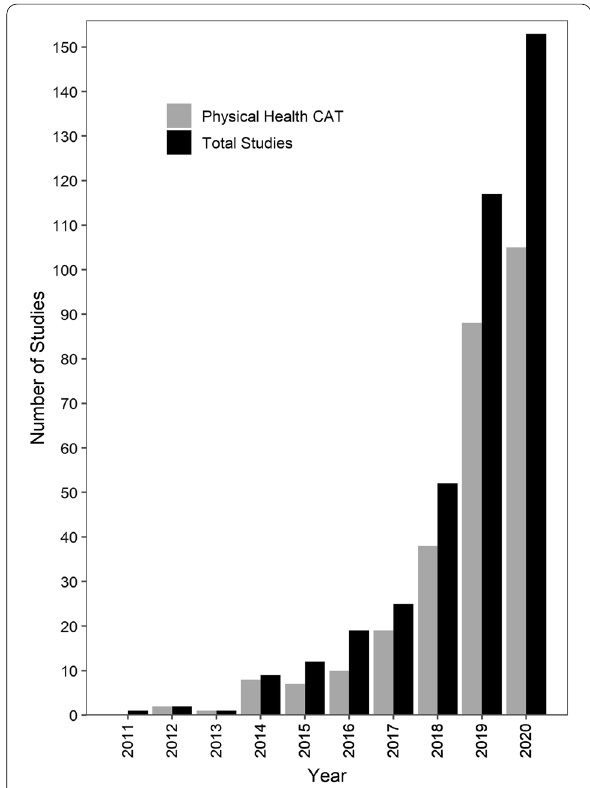
Fig. 2 Number of all adult orthopaedic surgery Patient-Reported Outcomes Information System (PROMIS) studies and PROMIS physical health computerized adaptive test (CAT) studies (Physical Function, Upper Extremity, and Lower Extremity) published each year